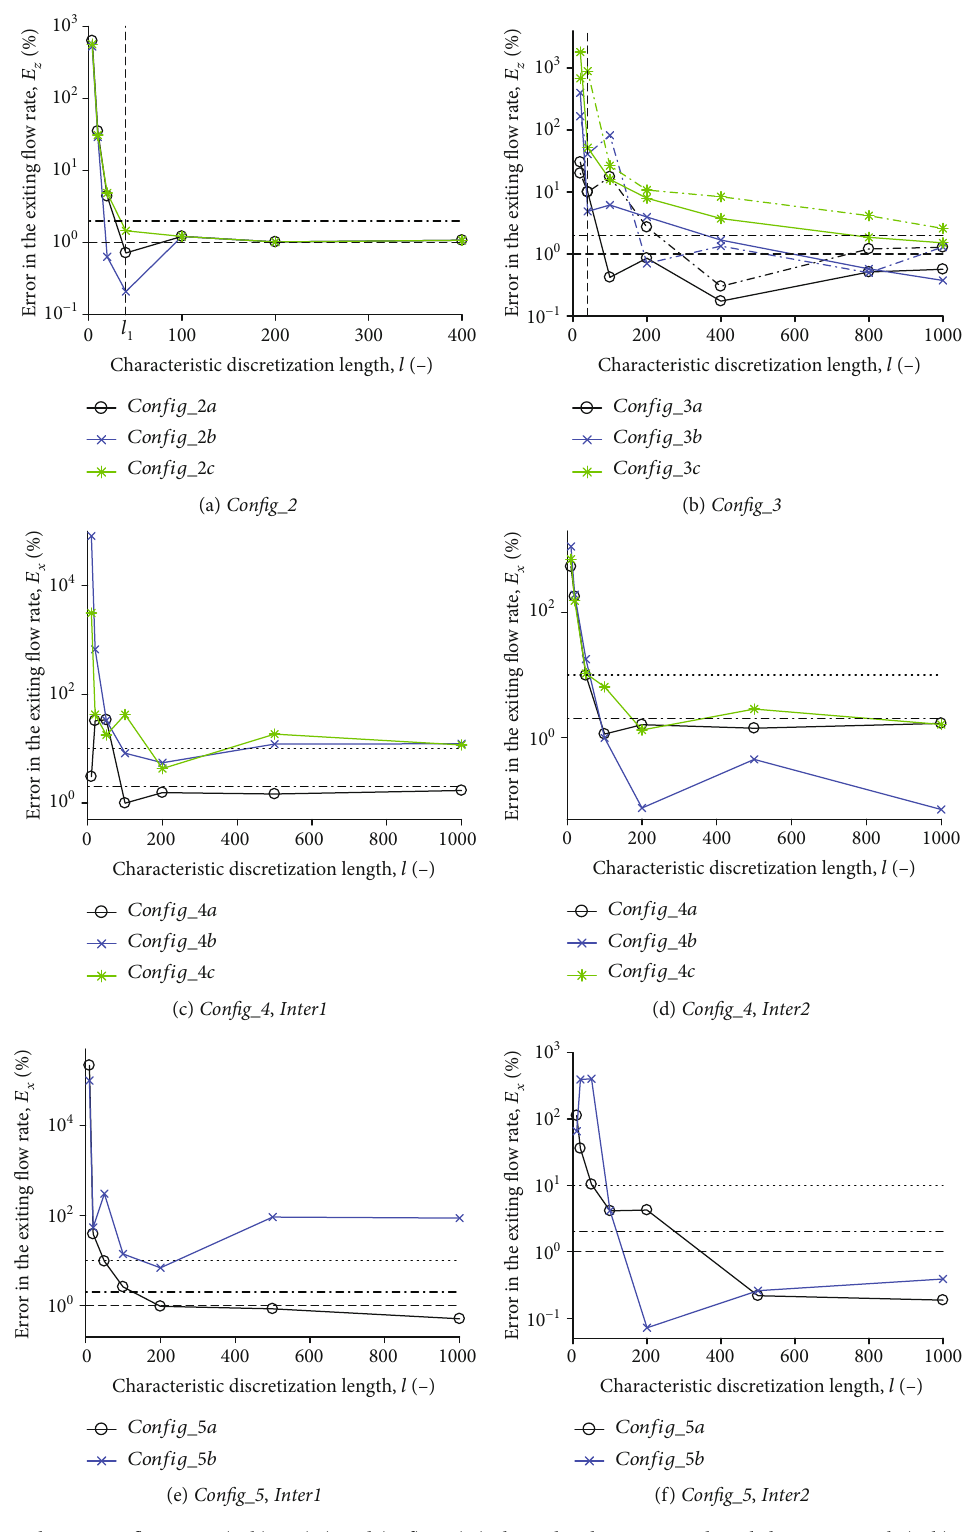
(%) and (c – f) E (%) along the characteristic length l = L / Δ with (a, b) L = 2 m and (c – f) z x disc